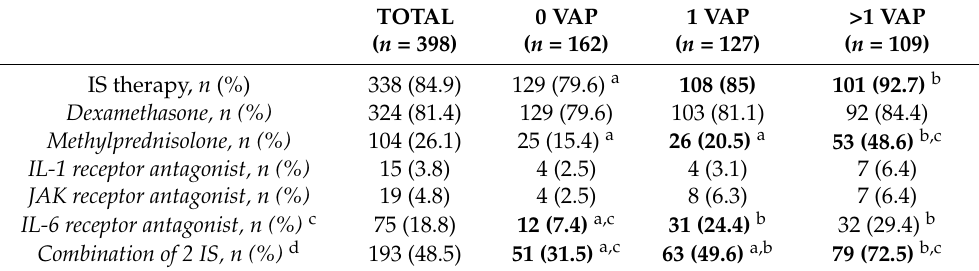
Table 2. Immunomodulator/immunosuppressive (IS) therapies received during the ICU stay.